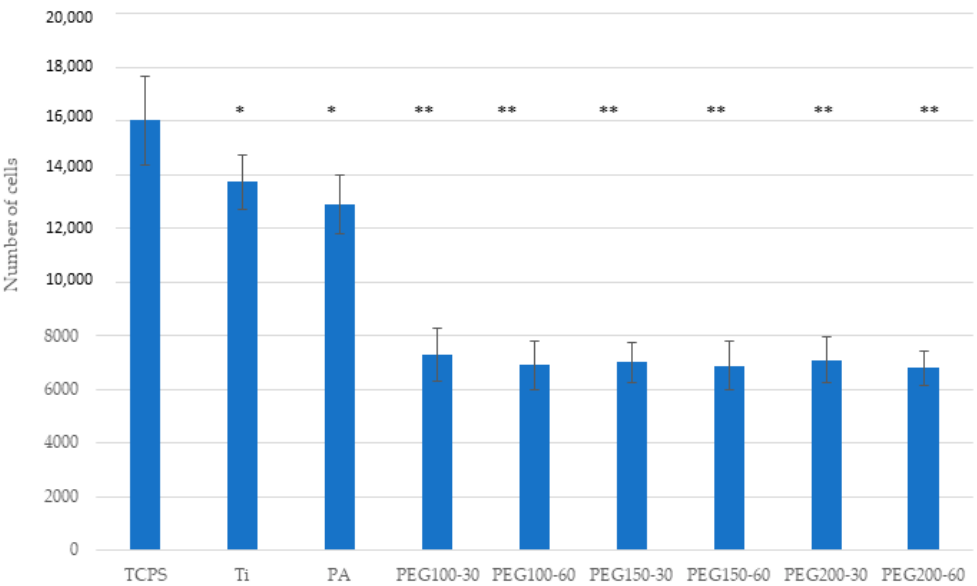
Figure 9. Cell adhesion of SaOS-2 on the Ti, PA and PEG samples. Bars indicated with the same symbol have no statistically significant difference between them ( p < 0.05).